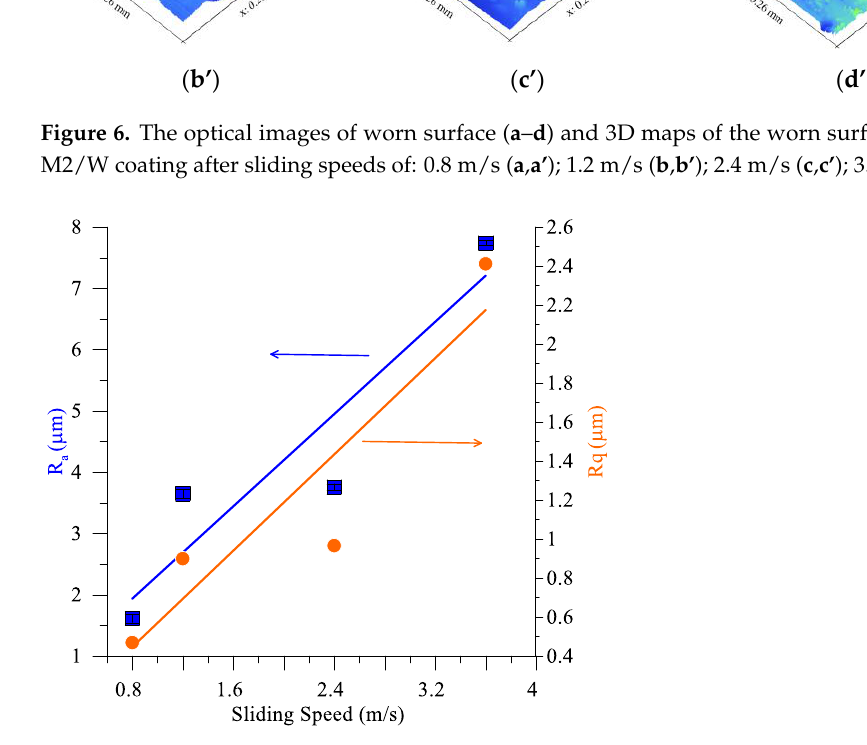
( b ) Figure 8. The optical images worn surface ( a ) and 3D map of the worn surface ( b ) of AISI 52 , 100 counterbody after sliding speed of 3.6 m/s. SEM studies show that samples tested at 0.8 and 1.2 м/ c allow directly observing the initial fishbone carbide microstructure of the as-deposited coating so that neither the me- chanically mixed layer (MML) nor any transferred material can be detected (Figures 9, Fig- ures 10, Table 2, Table 3). However, there are dark areas that, judging by their EDS spectra, contain much oxygen and iron and, therefore, can be identified as iron oxides (Figure 10b – d; Table 3; 7S – 9S). The areas occupied by carbide agglomerates still contain bright zones enriched with W (Figure 9d – f; Table 3; 13S – 15S) and grey zones additionally containing Mo, Fe, Cr, and V (Figure 9d – f; Table 3; 10S, 12S). All these EDS spectra show only minor concentrations of oxygen ( Tables 2 and 3).